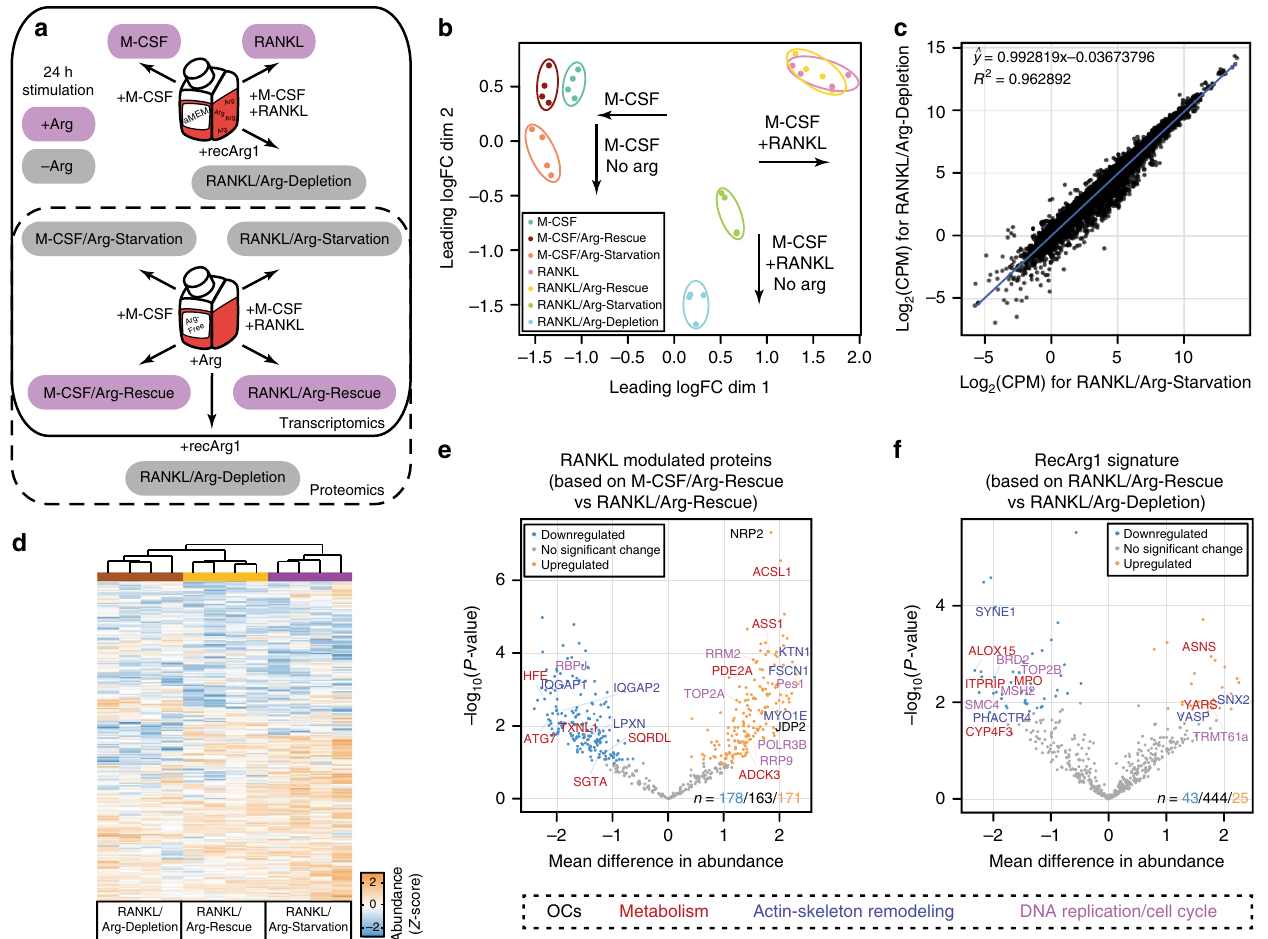
Fig. 3 Arginine presence speci fi cally sustains RANKL gene and protein expression. a Work fl ow dissecting recArg1 speci fi city on RANKL signalling. Arg- suf fi cient (pink) and Arg-de fi cient (grey) conditions in arginine suf fi cient (aMEM) or de fi cient media (Arg-Free) depicted. b MDS of transcriptomic datasets in a , keeping all genes expressed in at least three of the samples. c Linear regression of average gene expression ( n = 4) for RANKL/Arg- Depletion against RANKL/Arg-Starvation. d Heatmap of proteomics data in a , showing Z -score of abundance level per protein across all conditions (RANKL-conditions shown only, full heatmap in Supplementary Fig. 5d). e Volcano plot showing difference between M-CSF/Arg-Rescue versus RANKL/ Arg-Rescue ( n = 4). Highlighted are proteins modulated by RANKL in an arginine-dependent manner. f Volcano plot showing difference between RANKL/ Arg-Rescue versus RANKL/Arg-Depletion ( n = 4). Highlighted are proteins uniquely in fl uenced by